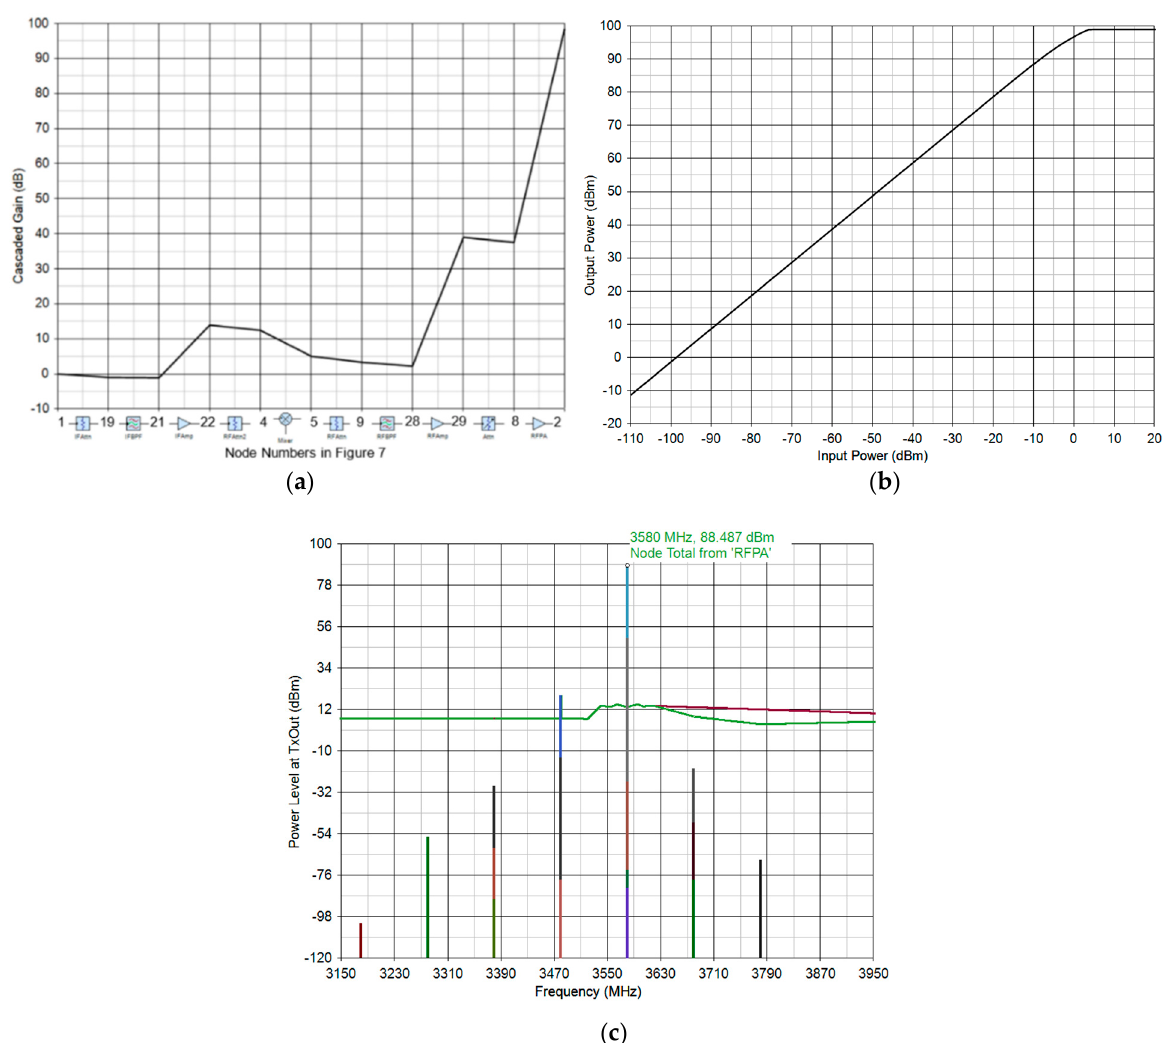
Figure A1. RF up-converter of TAR in TX_UpConv block of Figure 11.